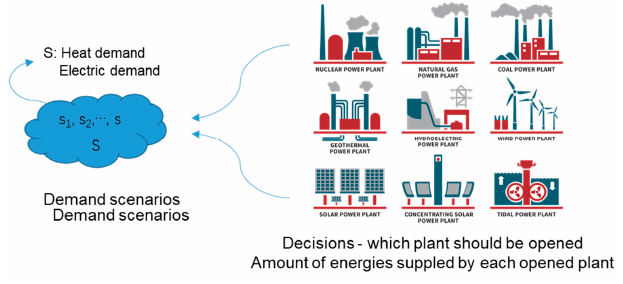
Figure 2. Illustration of the problem.